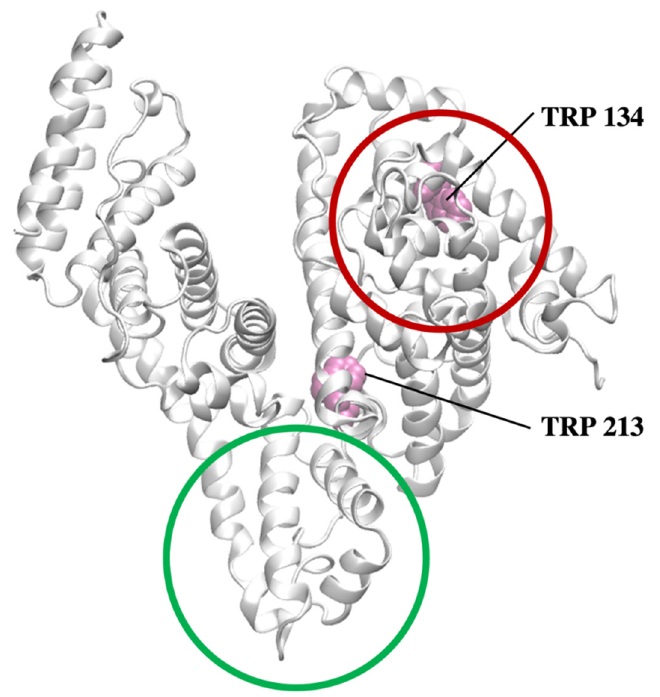
Figure 1. The secondary structure of BSA (grey cartoon) with marked Trp residues (magenta VDW representation). The first and second potential binding sites of SDS are shown with red and green rings, respectively.